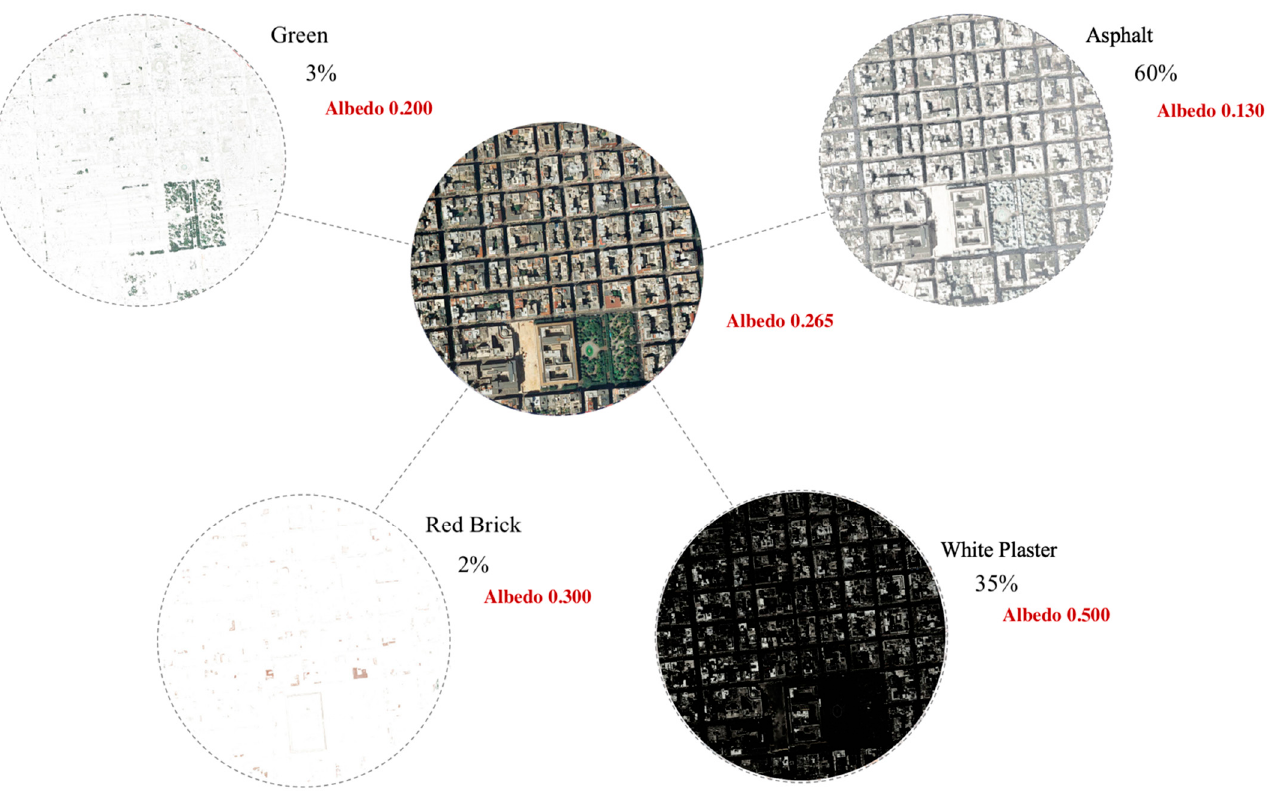
Figure 2. The image analysis to extract data of the characteristics of the city (example in Bari, Mu- rattiano, Italy). Murattiano,